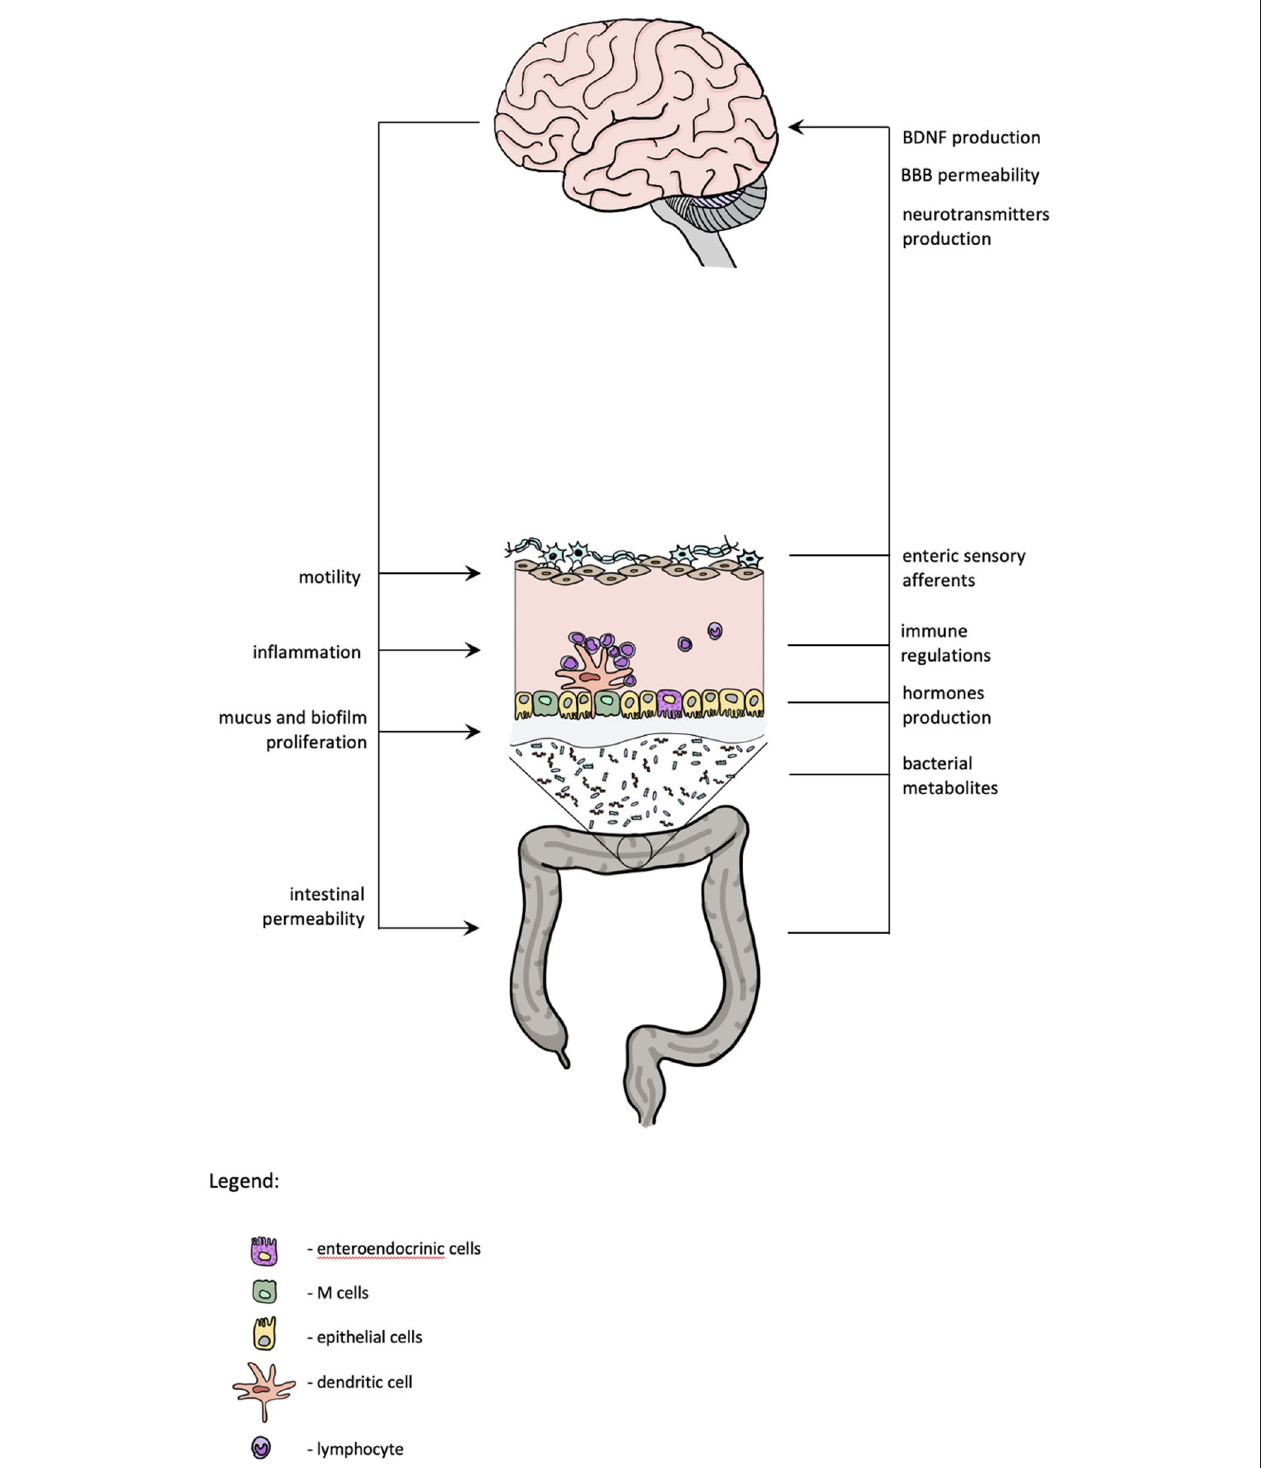
FIGURE 1 | Gut-brain axis and depression. The scheme summarizes the mutual interactions between central nervous system and gastrointestinal system. Functional changes in both might contribute to depression.